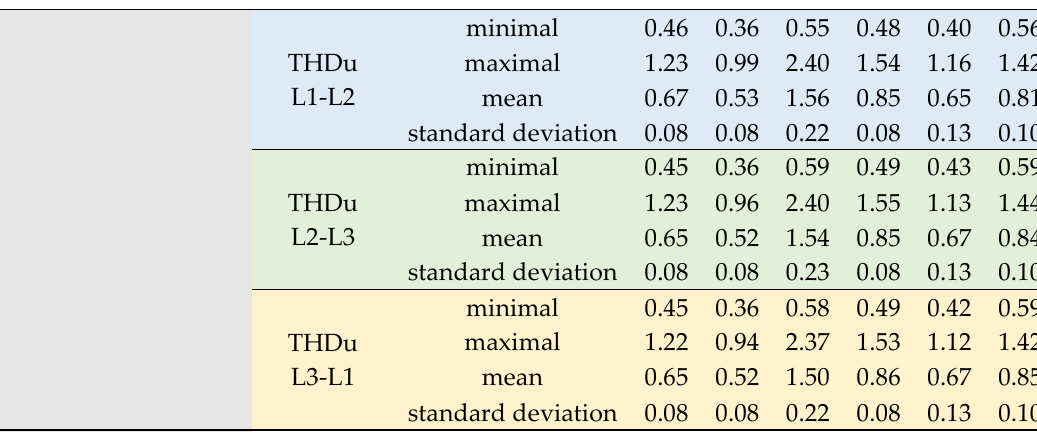
Table 2. Cont. Energies 2020 , 13 , x FOR PEER